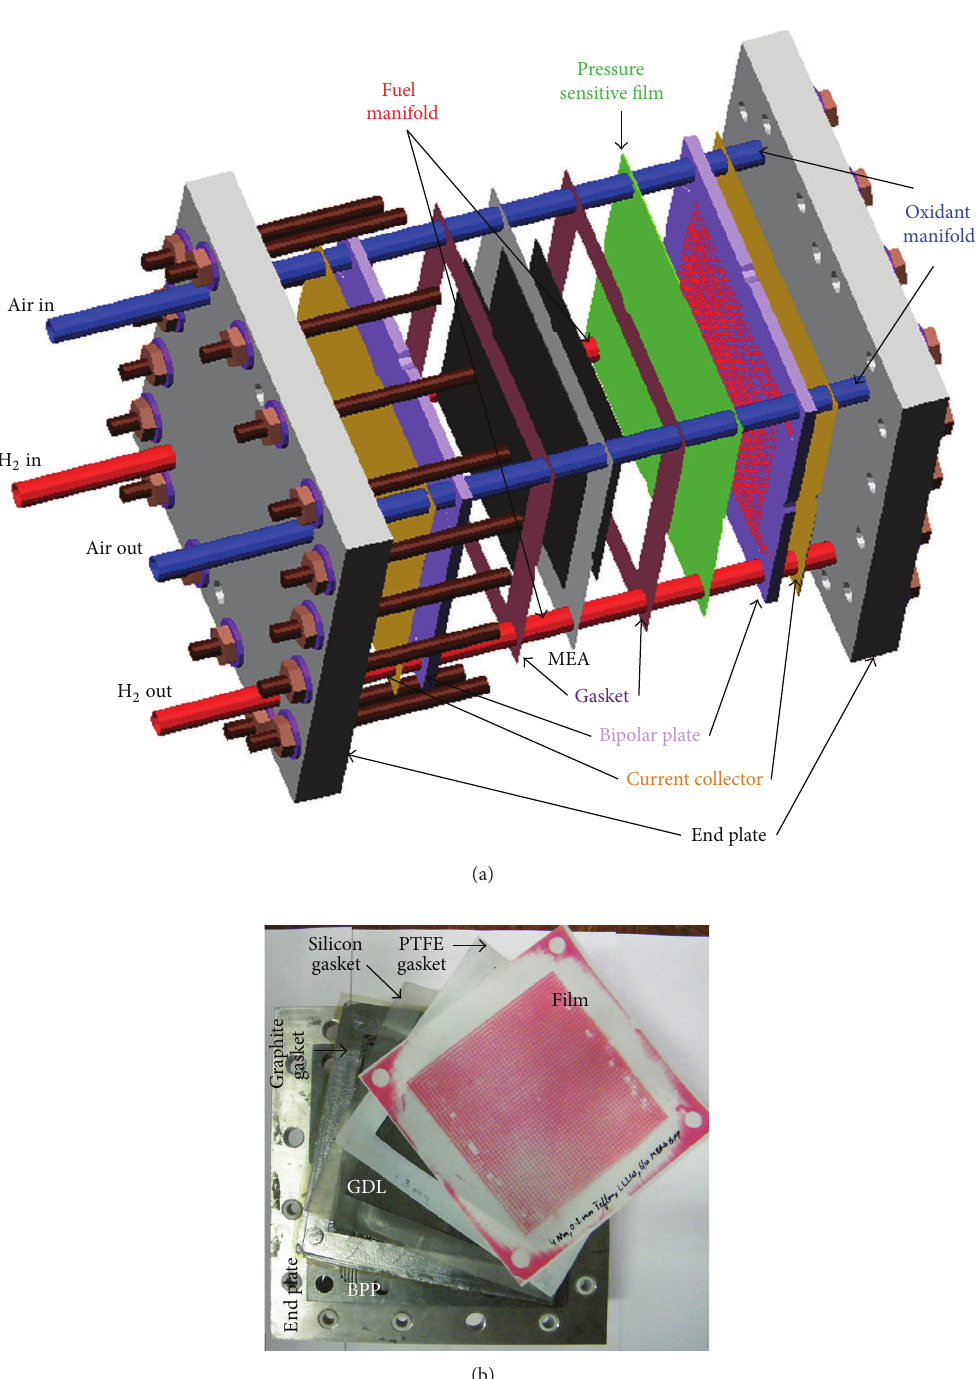
Figure 2: Experimental setup: (a) schematic diagram of the fuel cell with the pressure sensitive film and (b) fuel cell components.